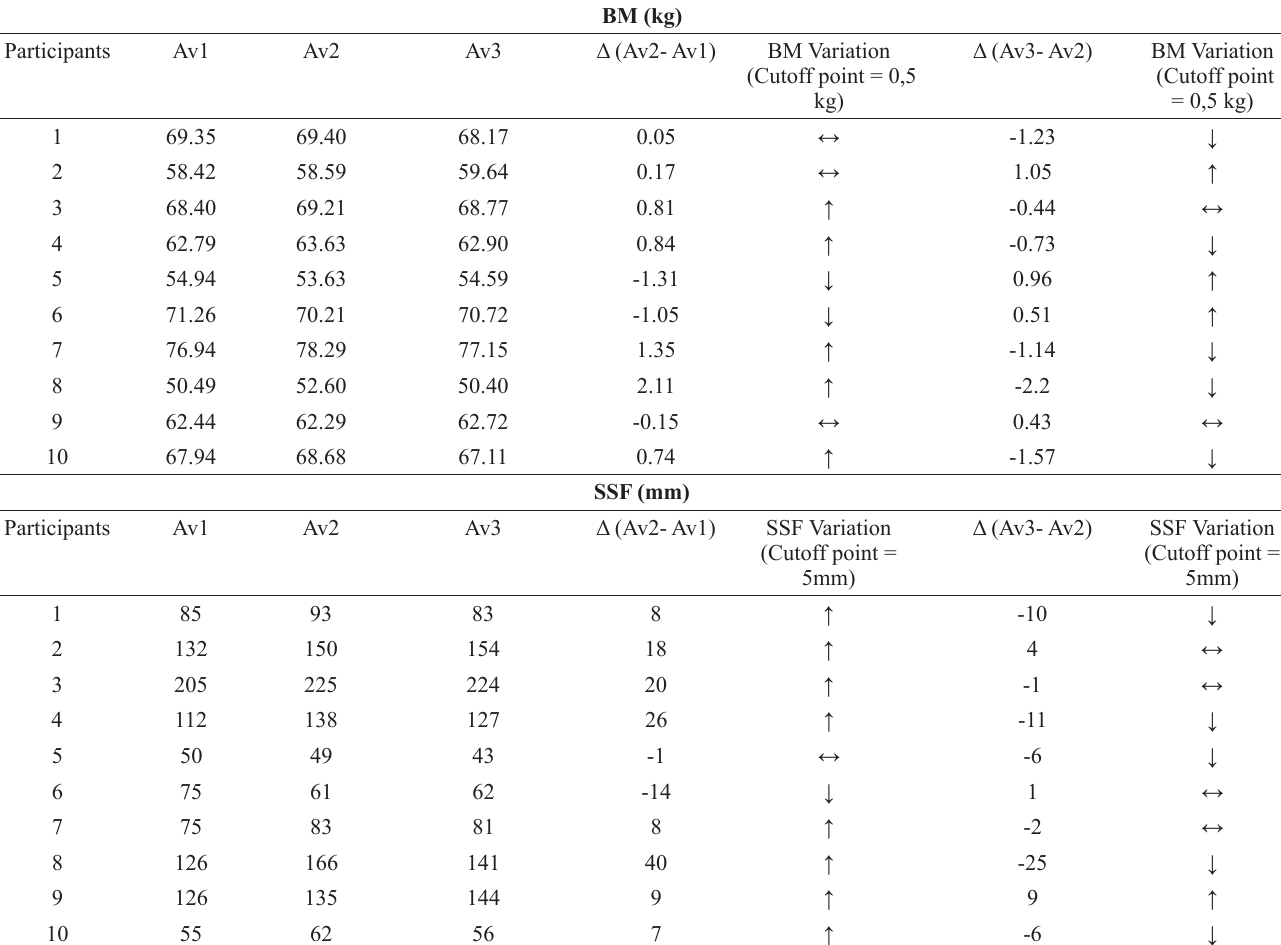
Table 2. Individual analysis of BM and SSF in each evaluated period and their variation between these